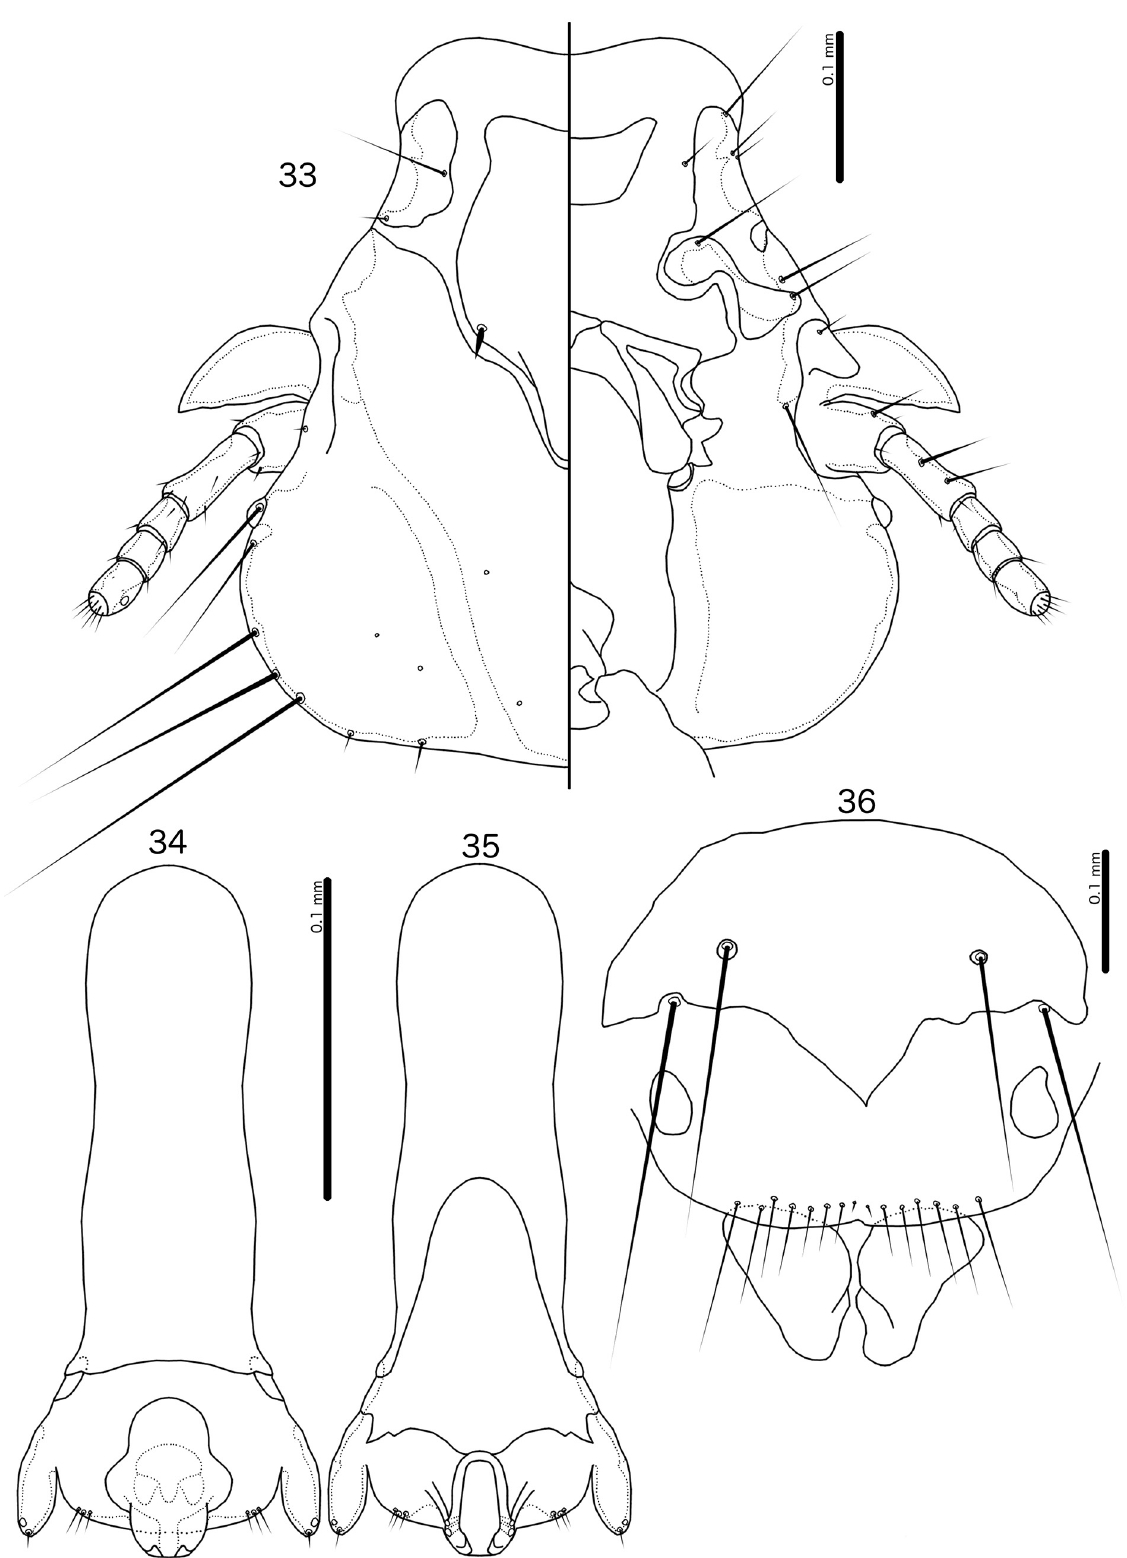
Figs 33–36. Philopterus stansburyensis sp. nov. ex Pheucticus melanocephalus melanocephalus (Swainson, 1827). 33 . Male head, dorsal and ventral views. 34 . Male genitalia, dorsal view. 35 . Male genitalia, ventral view. 36 . Female subgenital plate, vulval margin, and subvulval plates, ventral